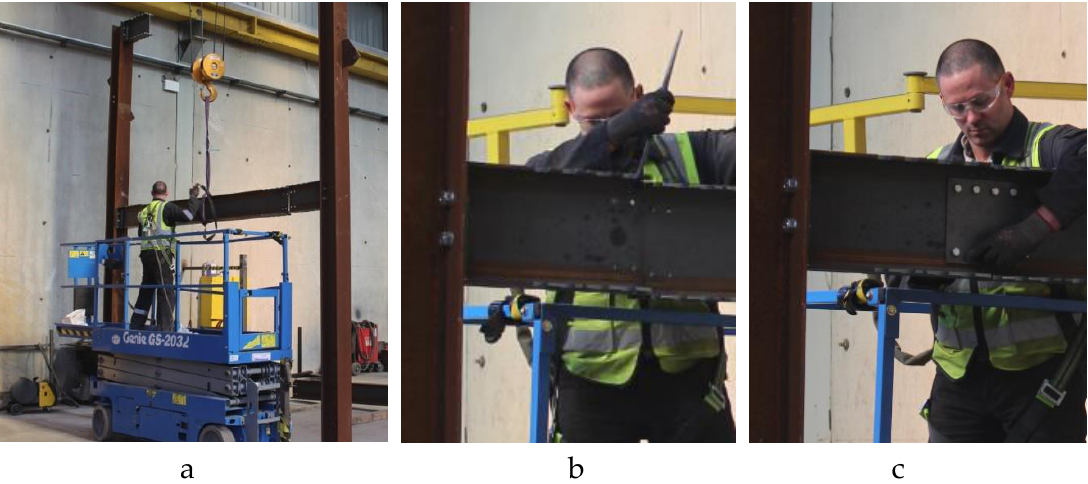
Figure 17. Erection of level 1 beam: ( a ) lowering level 1 beam into position; ( b ) using a podger spanner to align the beam; ( c ) bolting web splice plate.